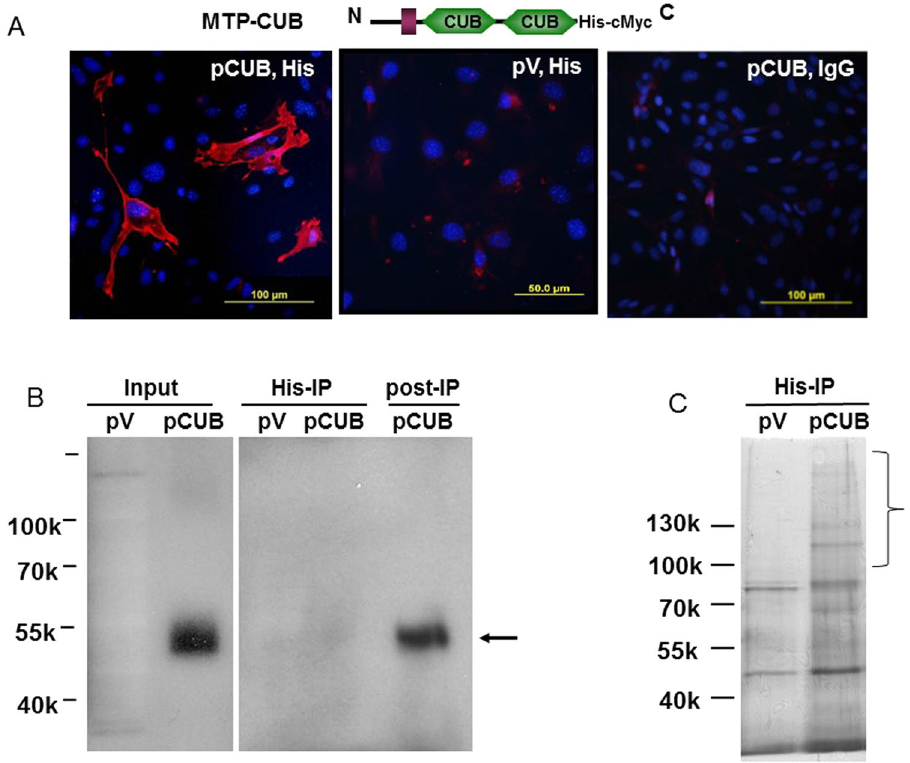
Figure 3. Expression of MTP CUB domains in brain endothelial cells isolates associated molecules. ( A ) Cell staining of MTP-CUB. Brain endothelial cells transfected with plasmid expressing MTP-CUB domains (structure shown in the diagram) carrying 6His and c-Myc tags (pCUB) or with the same expression vector without insert (pV). Cells were immunostained, without Triton X-100 treatment, with anti-His antibody (His) or control IgG of the same subtype (IgG). Nuclei are shown in blue. ( B ) Western blot detection of MTP-CUB in lysates prepared for “A” using anti-Myc antibody. Input: the total lysate of cells carrying MTP-CUB expression vector (pCUB) or the empty vector (pV). His-IP: anti-His antibody immunoprecipitated cell lysates released by DTT treatment. After releasing MTP-CUB associated protein (His-IP of pCUB), MTP-CUB protein was released from the antibody beads by urea in acidic condition that is shown in the lane labeled “post-IP pCUB”. Arrow indicates the expected CUB protein. ( C ) Silver staining of the proteins pulled down by